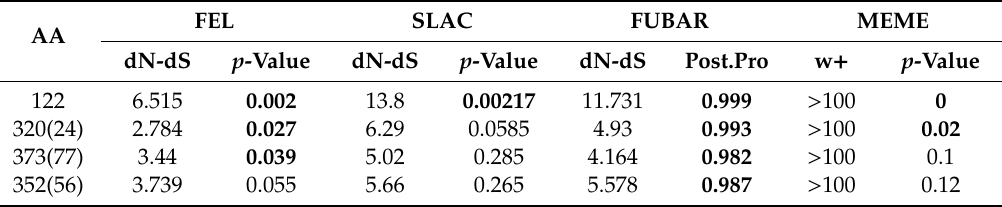
Table 3. Selection analysis of full-length